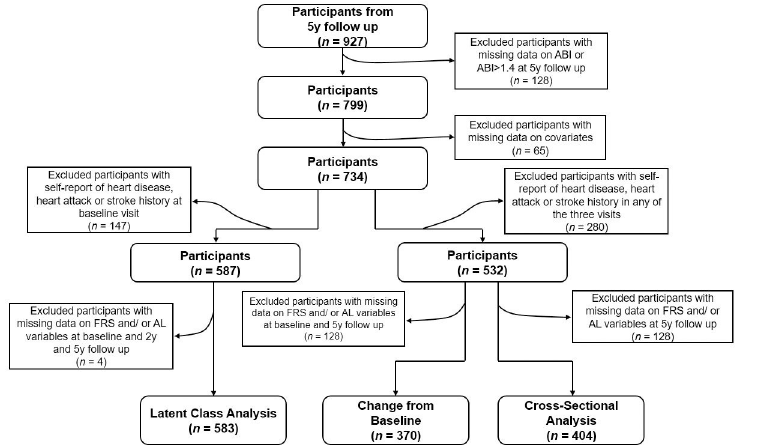
Fig 1. Flow chart of participation from the Boston Puerto Rican Health